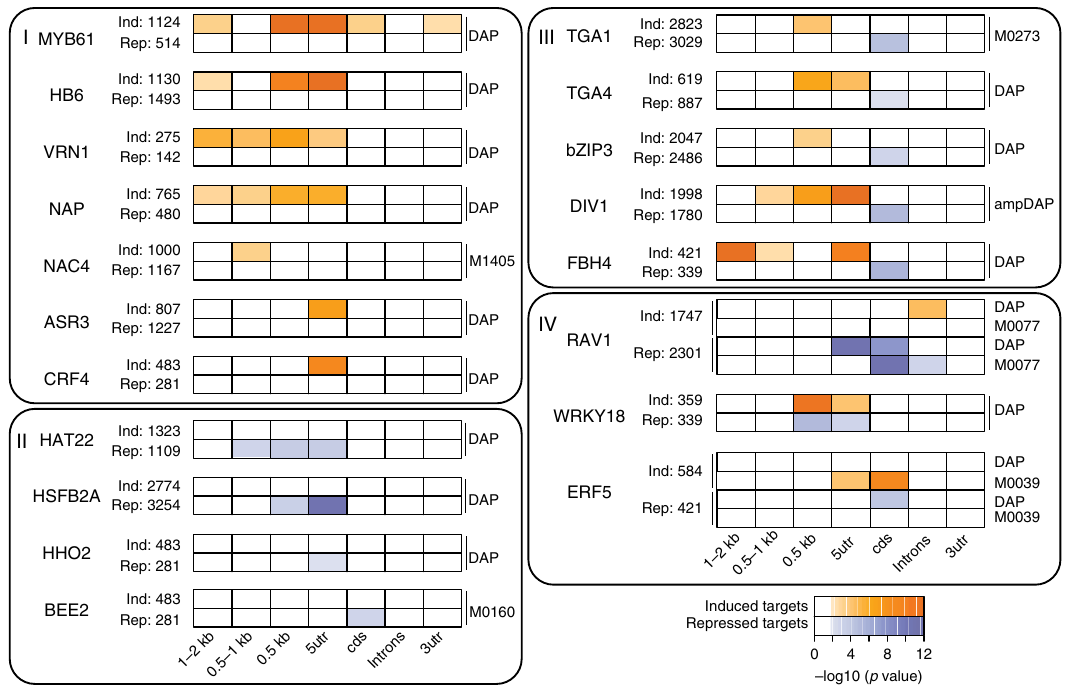
Fig. 4 Cis -motif enrichment in distinct genic regions is associated with transcription factor (TF) induction or TF repression. TF perturbation assays of the 33 nitrogen (N)-early response TFs in root cells reveals that each TF can act both as an inducer and a repressor of direct target genes (number of targets indicated to the right of TF name). Enrichment analysis revealed that TF cis -binding motifs are often speci fi c to a particular type of regulation (e.g., induction vs. repression). Cis -motif data available for 21/33 TFs enabled us to classify these TFs into four groups. Targets identi fi ed by the cell-based TARGET (Transient Assay Reporting Genome-wide Effects of Transcription factors) assay uncovered TFs whose known cis -motifs are associated with induction of targets (group I) and TFs with cis -motifs associated with repression of targets (group II). Another group of TFs (group III), including all the bZIP family members in this study, showed cis -motif enrichment in the promoter or 5 ’ untranslated region (UTR) of induced targets, while repressed targets only were enriched for the cis -motif in the coding sequence (CDS). The fi nal set of TFs (group IV) showed enrichment of their known cis -motifs in the overlapping regions of both induced and repressed targets. HHO3 and TCP23 showed no enrichment of their cis -motifs in any region and are not shown. One or two representative motifs for each TF from the following sources are shown: DNA af fi nity puri fi cation sequencing (DAP-seq) 5 with genomic DNA (DAP), DAP-seq with PCR-ampli fi ed gDNA (ampDAP), and Cis-BP 38 (labeled with motif ID). Orange shading (induced targets) and blue shading (repressed targets) represents the enrichment of motifs as calculated using the AME tool within the MEME suite 69 , with p values determined using Fisher's exact test. Results for all cis -motifs can be found in Supplementary Data